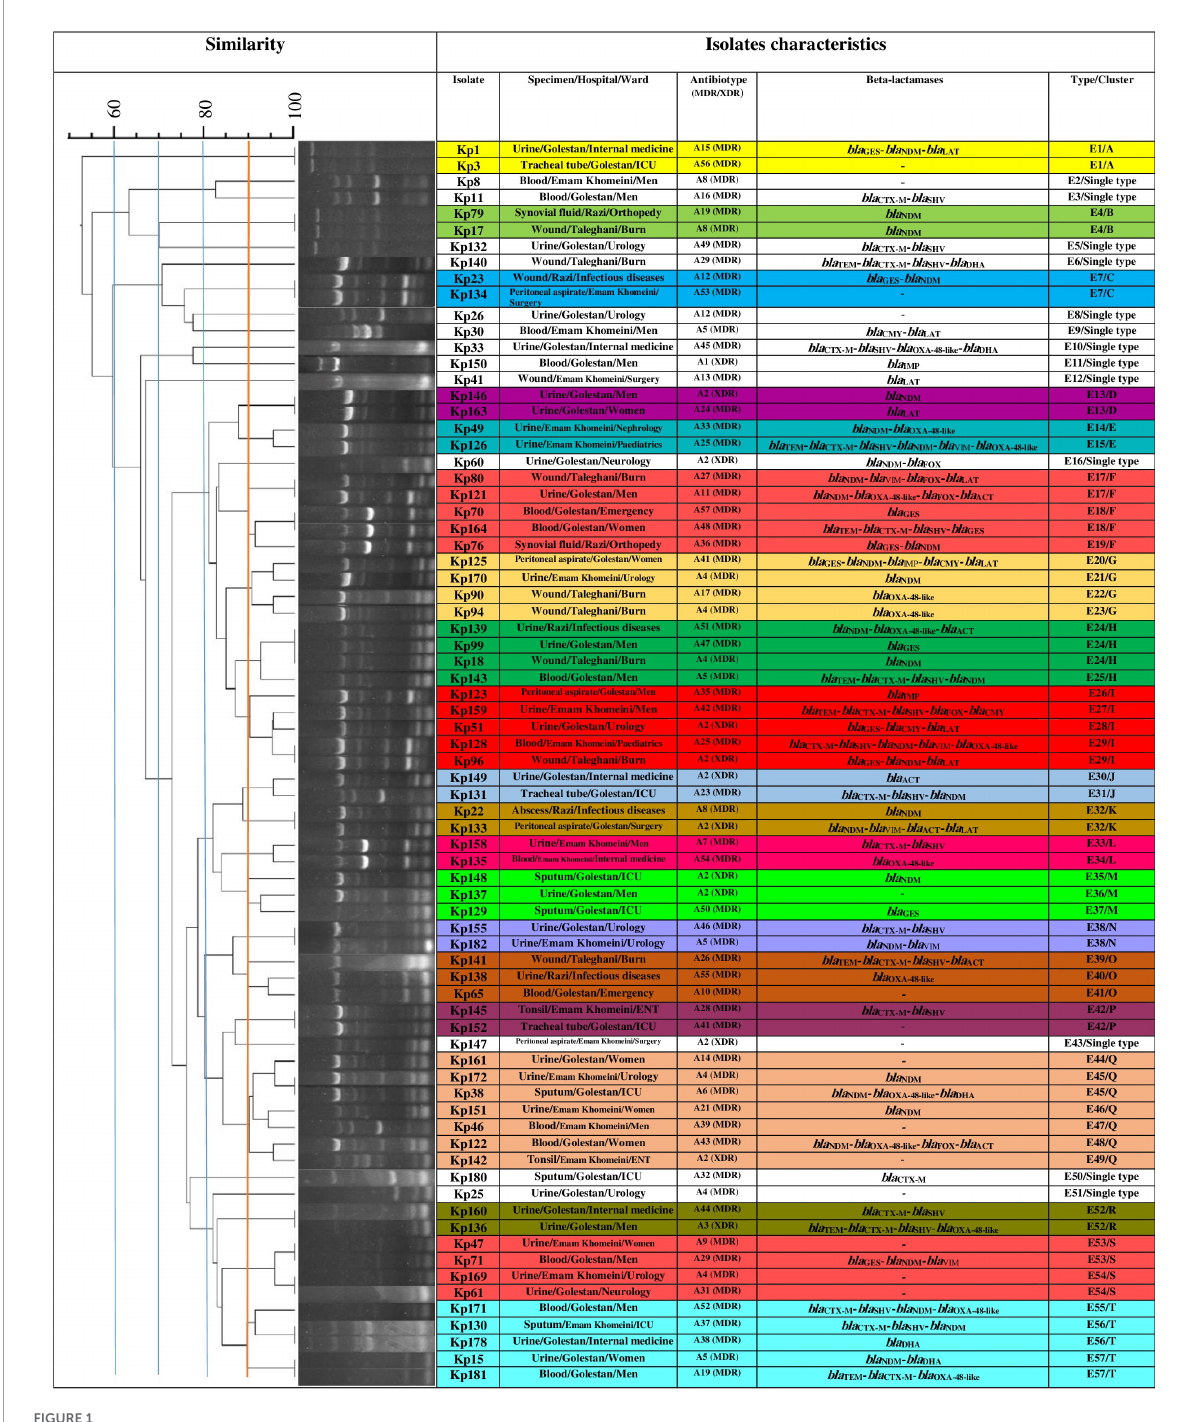
FIGURE1 Clonal relatedness of 75 carbapenem-resistant classic Klebsiella pneumoniae using ERIC-PCR. Based on the UPGMA and Dice similarity coefficient, the isolates were assigned to 20 clusters and 13 singletons.